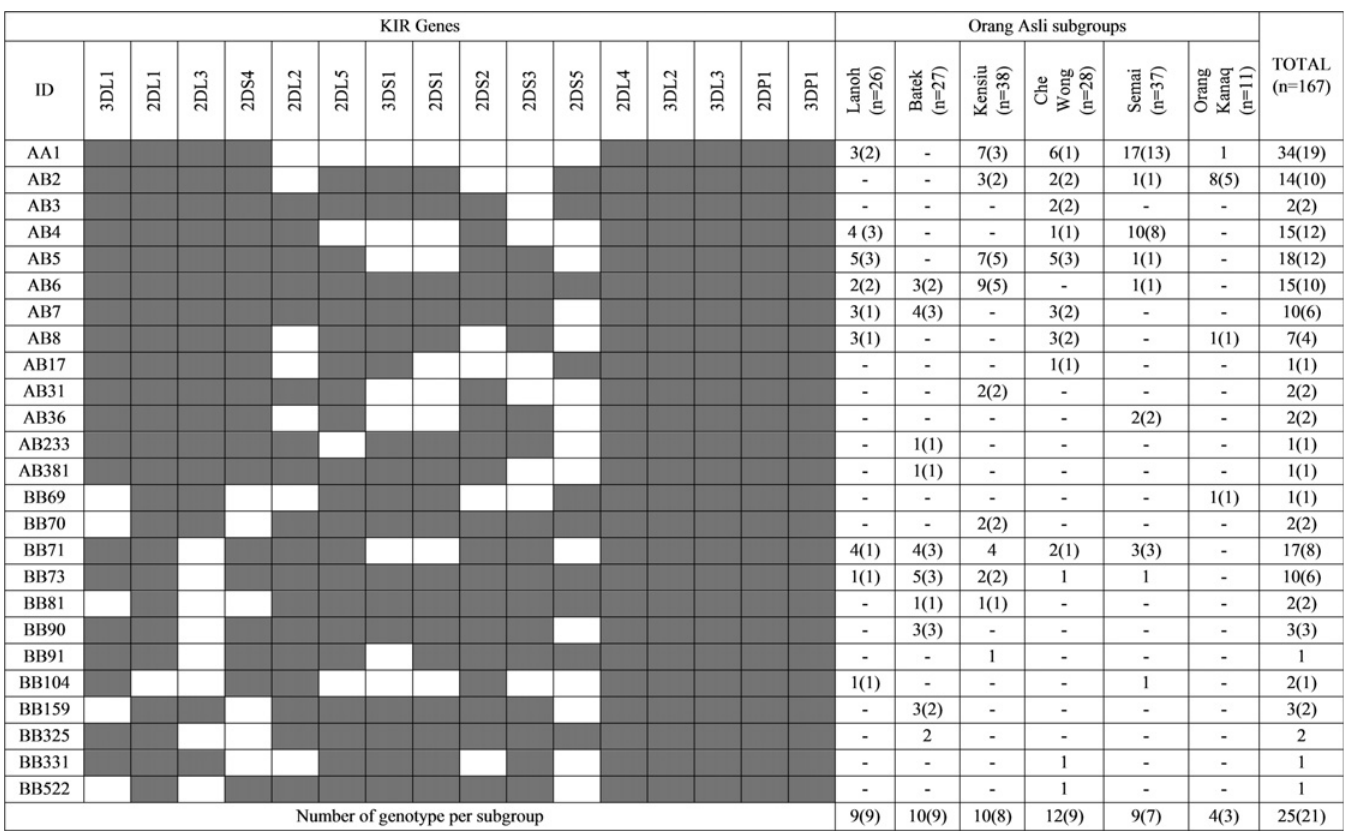
Fig 1. The KIR genotype profiles of six OA subgroups in Peninsular Malaysia. ID is the genotype number assigned by Allele Frequency Net Database [15]. Numbers in brackets represent the ‘ unrelated sample ’ of OA subgroups.